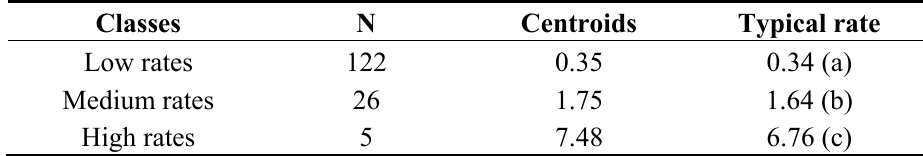
Table 6. Average incidence rates (centroids) and typical incidence rates as results of a univariate cluster